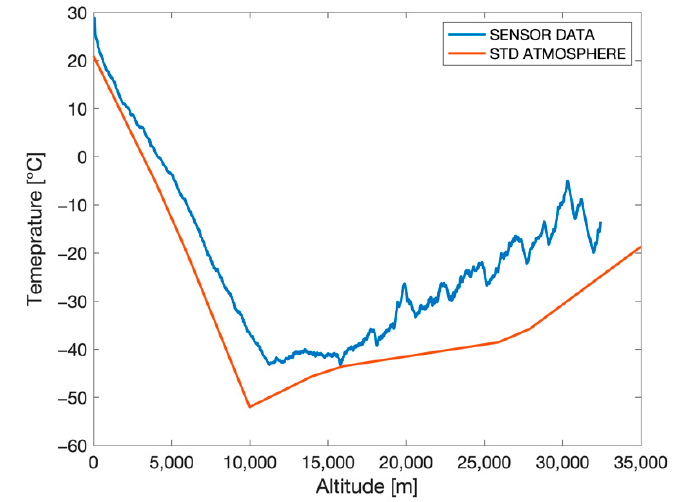
Figure 12. Measured external temperature as a function of altitude (blue line). The temperature predicted by the Standard Atmosphere model is shown for the sake of comparison (red line).